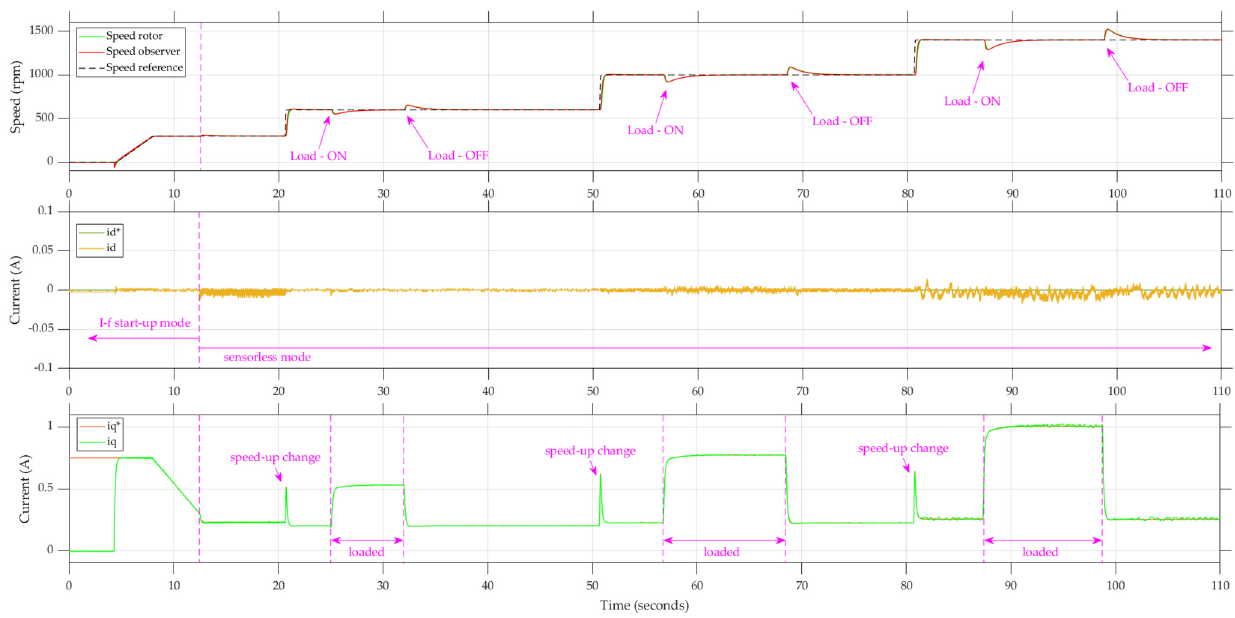
Figure 19. Experimental results for speed and current response to load variation.